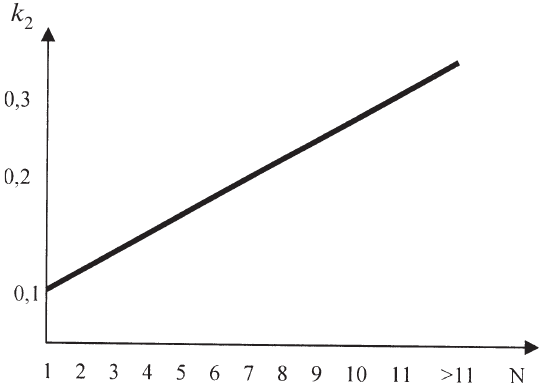
Fig 3. Trend of the weight of the traffic conditions factor for the Baltic Sea (N – number of highly dense traffic